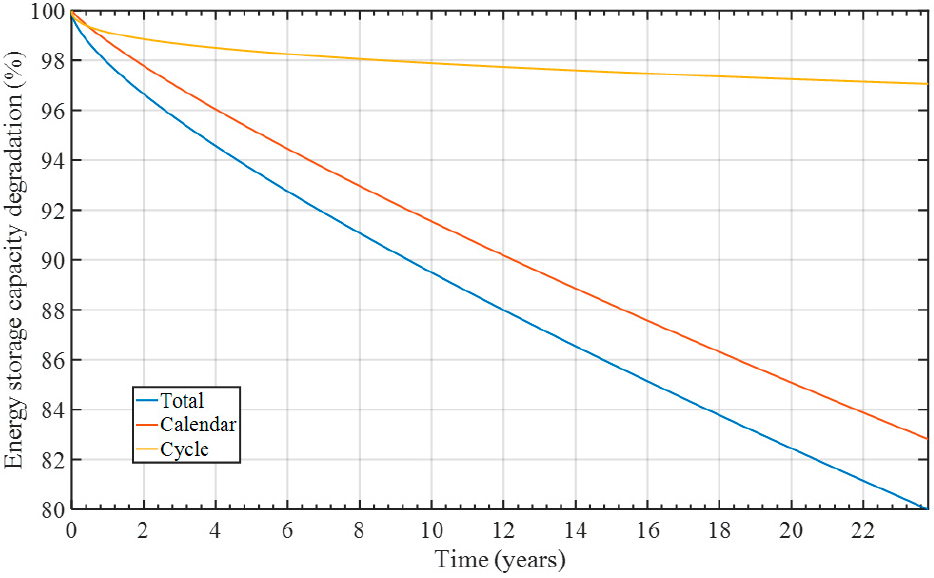
Figure 10. Capacity degradation by life